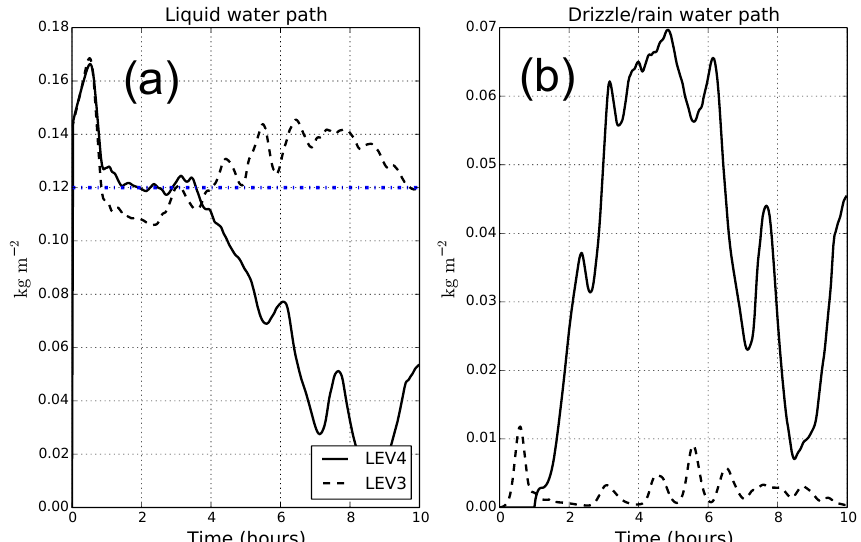
Figure 3. (a) Liquid water path, interpreted as the total mass of water, including both cloud droplets and drizzle. (b) Rain water path, taken as the water mass diagnosed from precipitation bins only. Results from LEV3 are shown with a dashed line while those from LEV4 are shown with a solid line. The horizontal blue dashed line in panel (a) represents the observed flight mean liquid water path at 120g m − 2 as reported by Stevens et al.